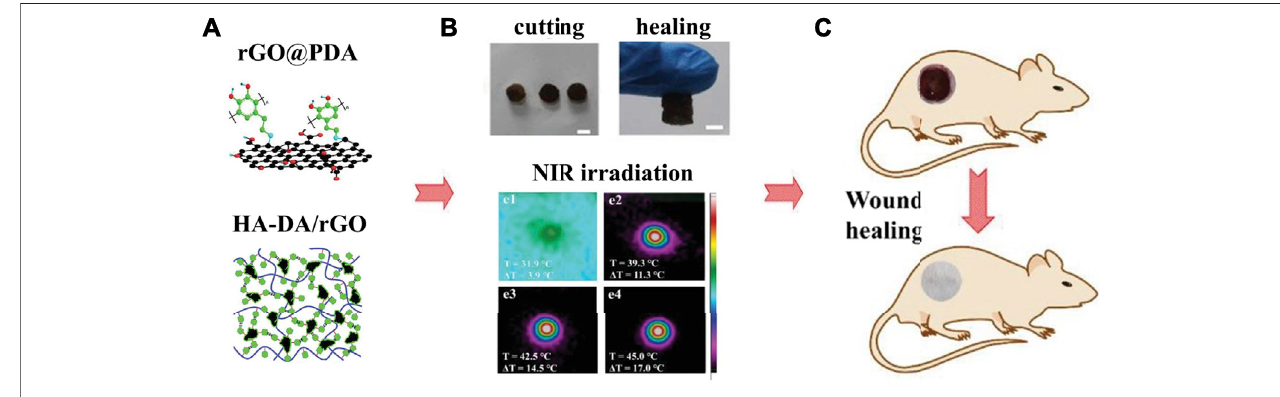
FIGURE 4 | Adhesive injectable composite HA-DA/rGO hydrogels with photothermal antibacterial activity promoted skin regeneration in mouse wound healing (Liang et al., 2019a).